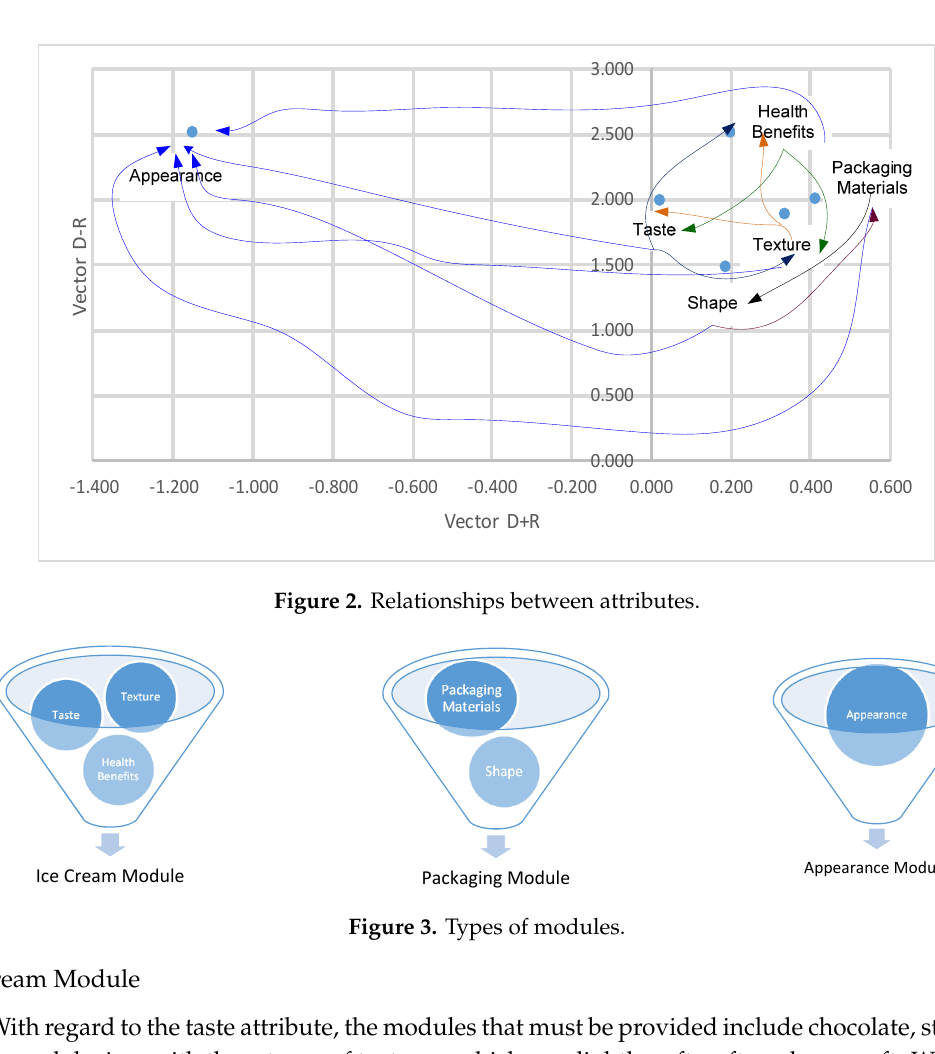
Figure 3. Types of modules.